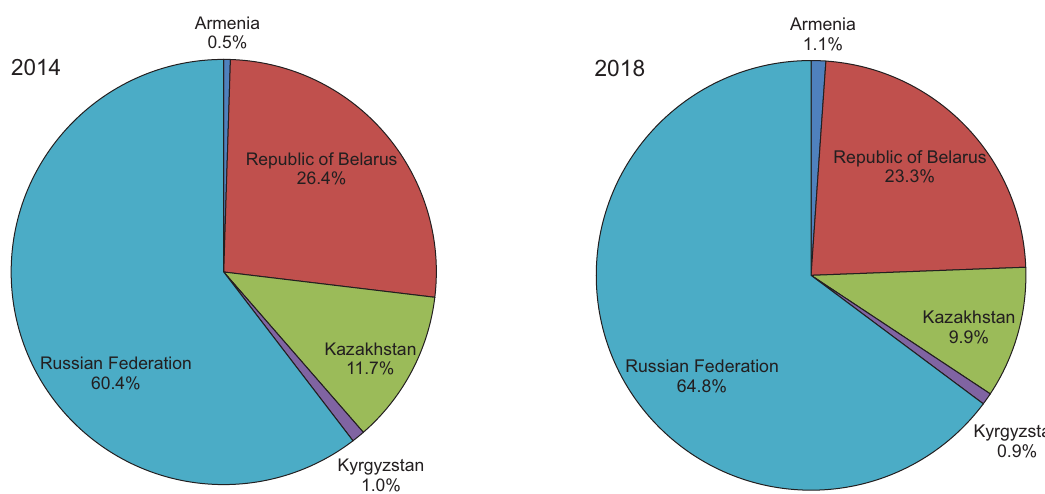
Fig. 2. Share of the EAEU member states in mutual merchandise exports. Source: own study based on the Eurasian Economic commission